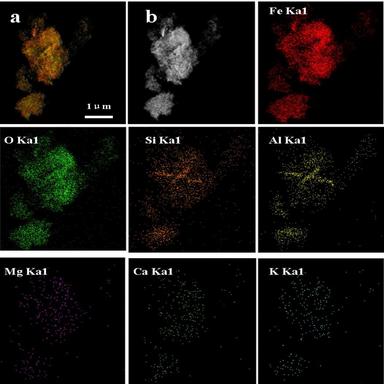
TEM image (a) and (b) with energy-dispersive X-ray mapping for different elements (Fe, O, Si, Al, Mg, Ca, and K) of Fe3O4/rectorite.